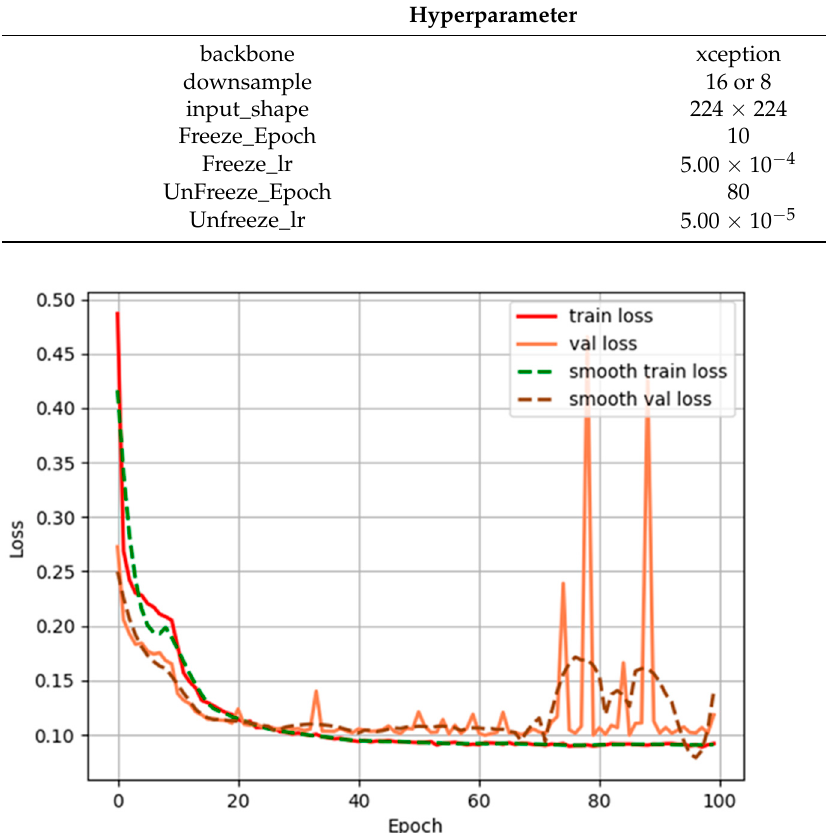
Figure 7. The training process of Deeplab-V3plus.